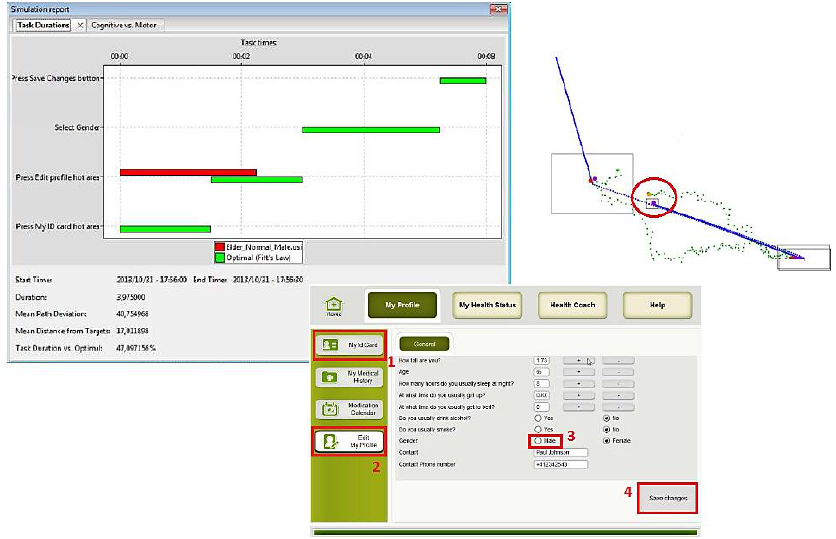
Figure 10. User 1 Cognitive VUM simulation: Edit health profile.